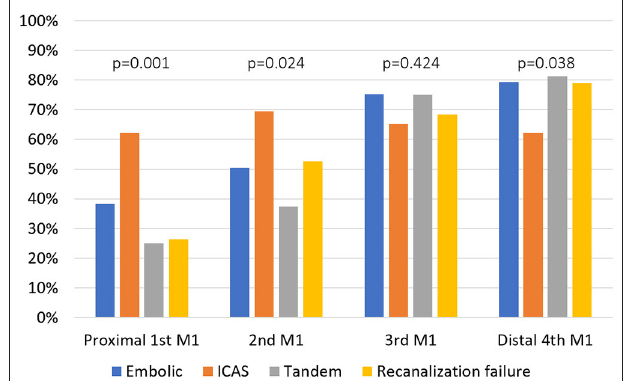
FIGURE 2 | Comparison of hyperdense artery signs on the four respective segments of M1 segment between the groups. MCA, middle cerebral artery; ICAS, intracranial atherosclerotic stenosis.